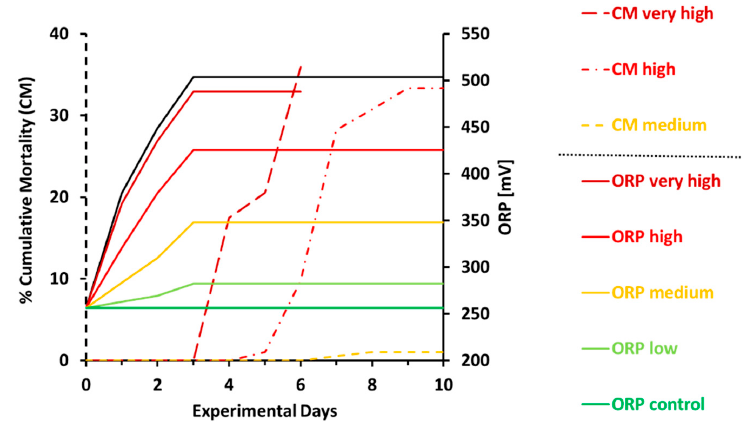
Figure 1. Mean cumulative treatment mortality (CM [%]; n = 3; dashed lines) and daily ozone dosage (solid lines) given as ORP = oxidation reduction potential [mV] during the experimental days. Control = 250 (228.0 ± 9.6) mV; low = 300 (282.3 ± 5.5) mV; medium = 350 (347.7 ± 5.5) mV; high = 425 (425.3 ±